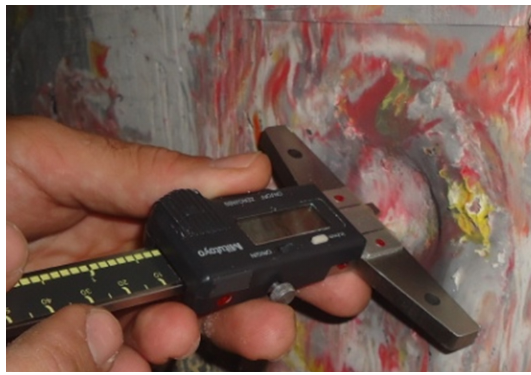
Figure 3. Measurement of the depth of penetration in the clay witness caused by the projectile impact.